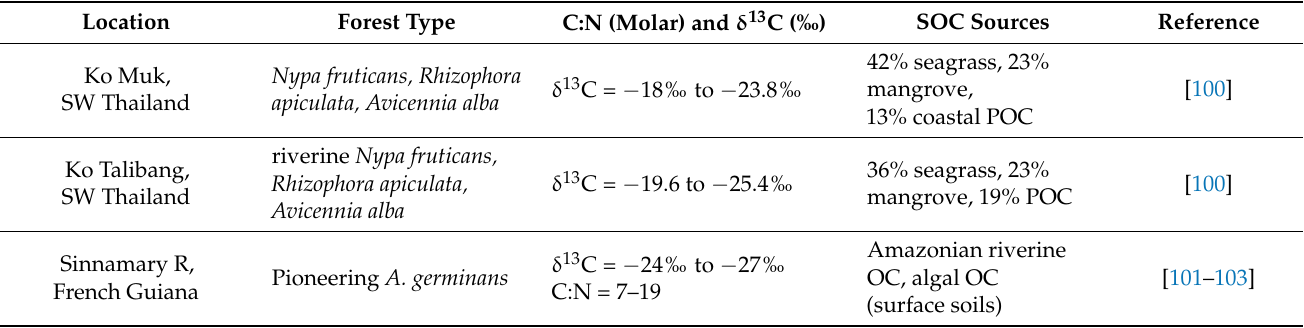
Table 4. Differences in sources, δ 13 C signatures and C:N ratios of soil organic carbon (SOC) in various mangrove forests